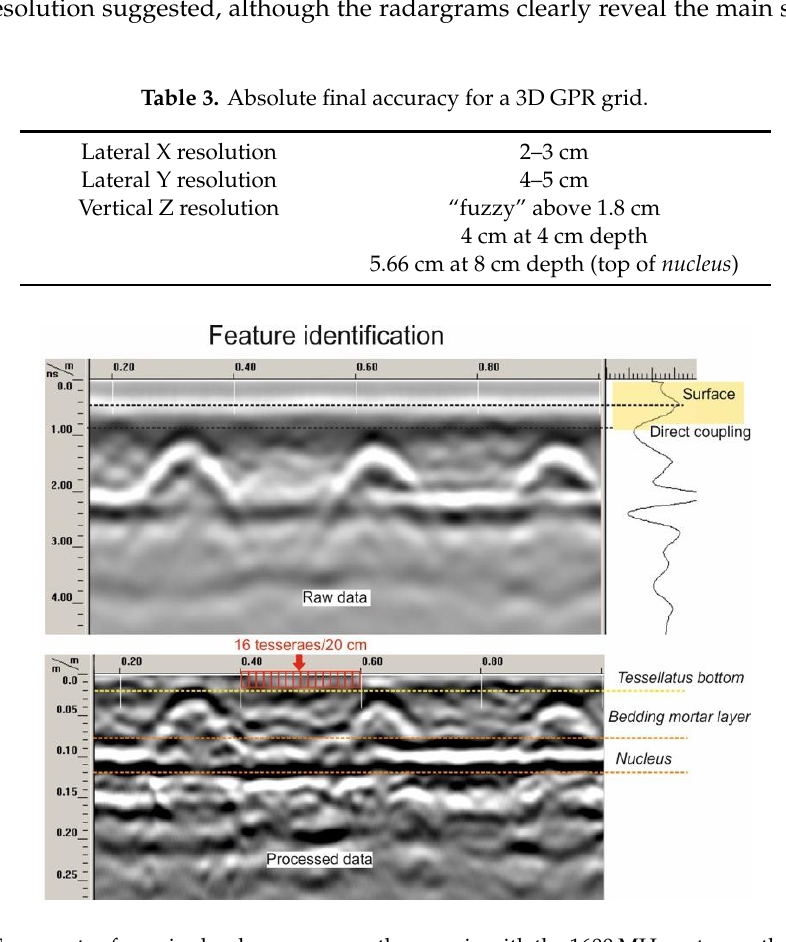
Table 2. Most relevant flow processing steps.